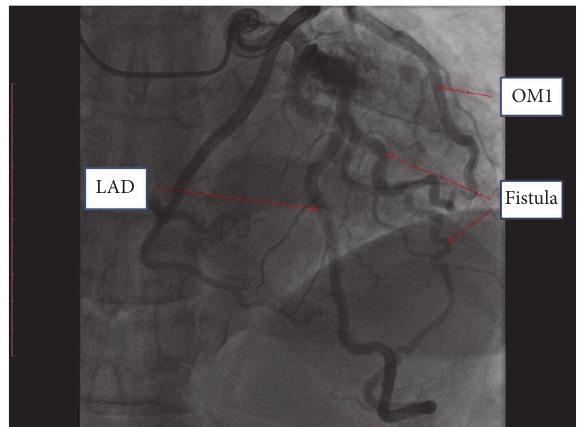
Figure 2: Coronary angiogram showing a fistula connecting distal left anterior descending artery (LAD) and first obtuse marginal artery (OM1) to the left ventricular